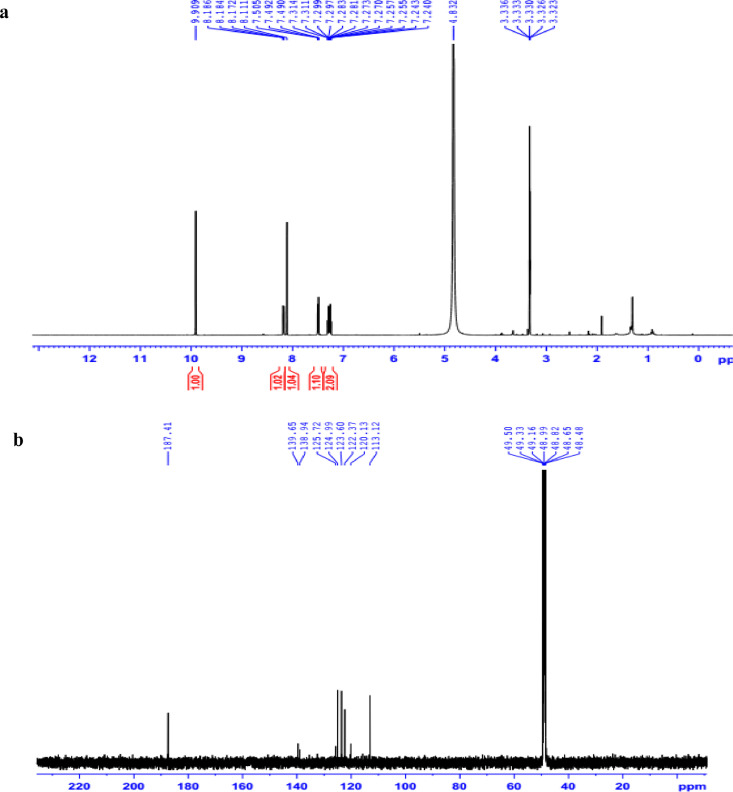
a. 1H NMR (500 MHz, CD3OD) of 7, b. 13C NMR (125 MHz, CD3OD) of 7, c. HSQC of 7, d. HMBC of 7, e. (-) APCI-MS of 7.